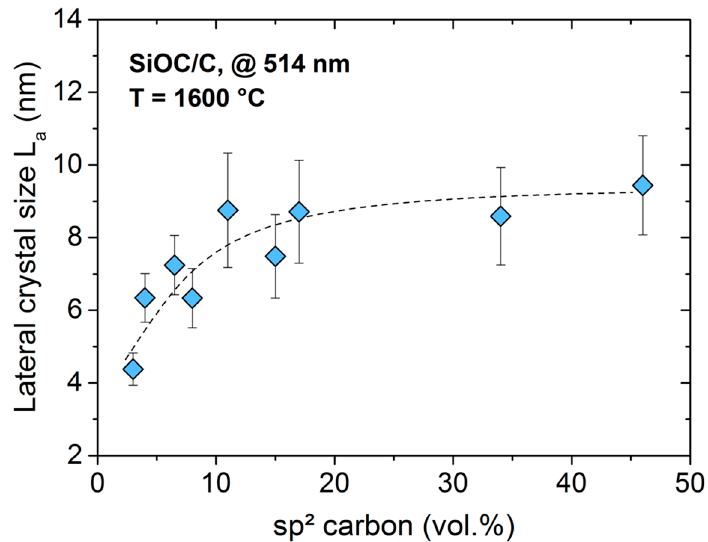
Figure 3. Plot of the lateral crystal size L a (blue diamonds) as a function of the amount of carbon. Bars represent standard deviation.